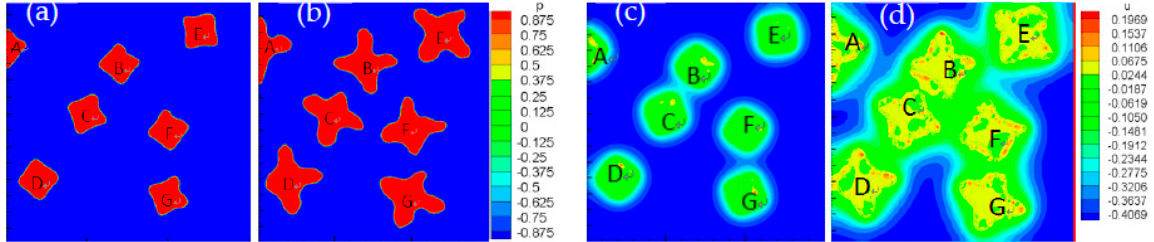
Figure 10. γ = 0.04, ∆ = − 0.45, ( a , b ) phase fields of polycrystalline silicon crystal at t = 30,000 ∆ t and t = 75,000 ∆ t, respectively; panels ( c , d ) are the temperature fields of polycrystalline silicon crystal at t = 30,000 Δ t and t = 75,000 Δ t, respectively.